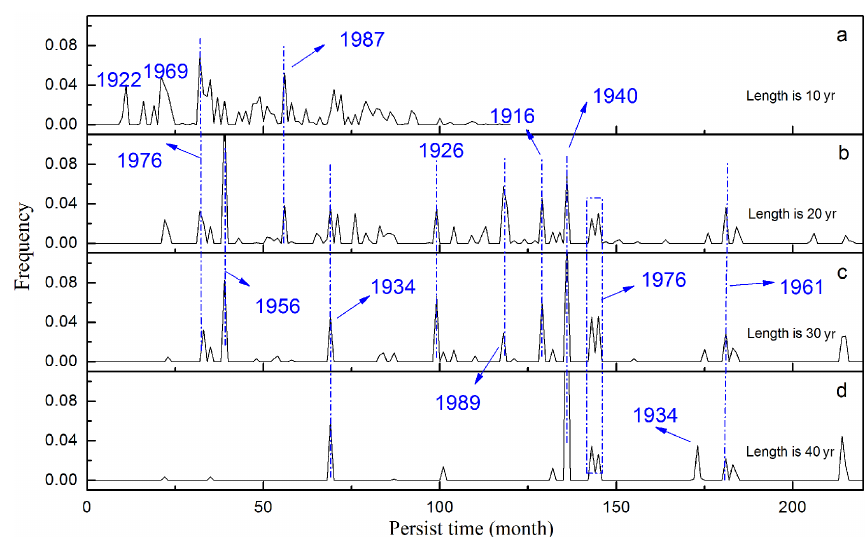
Figure 9. Distribution of the abrupt change persist time with the start moment. (a–d) show the different conditions in which the length of the sub-sequence are set, which are 10a, 20a, 30a, and 40a. The x axis refers to the persist time of the abrupt change, the y axis refers to the frequency of the abrupt changes that satisfies the conditions, and the characters mark the start moments of each abrupt change process.